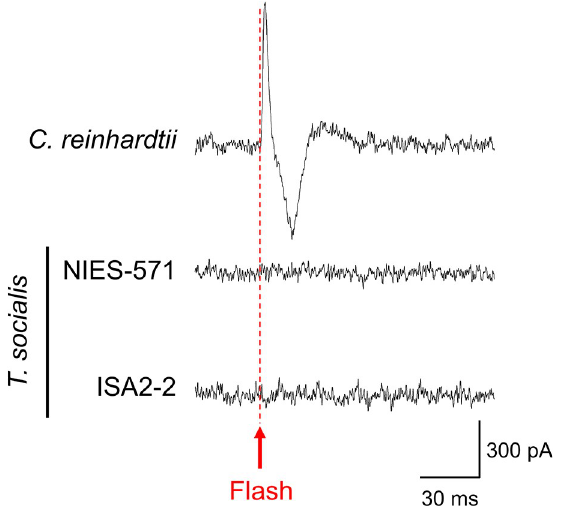
Fig 4. Photoreceptor currents were not detected in Tetrabaena socialis after a flash illumination. Representative photoreceptive currents in wild-type C . reinhardtii cells (1.0 × 10 7 cells/mL) and NIES-571 and ISA2-2 T . socialis colonies (2.5 × 10 6 colonies/mL). The flashlight illumination is indicated with a red arrow and a broken line. The experimental setup is shown in S4 Fig.